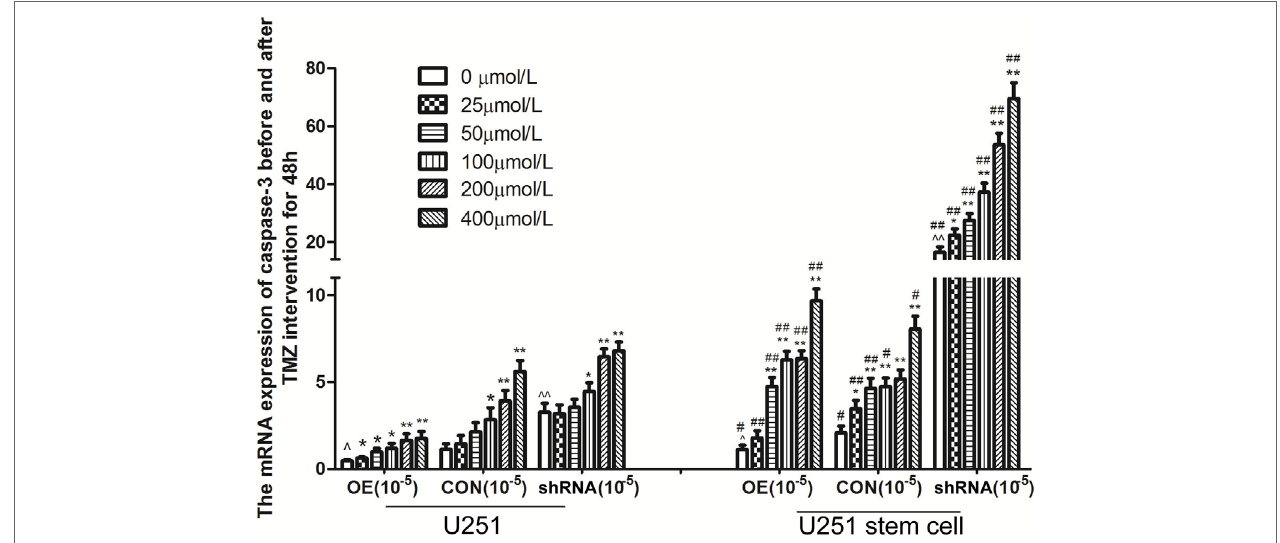
FigUre 8 | The mRNA expression of caspase-3 before and after temozolomide (TMZ) intervention for 48 h in U251 cells and stem cells. Data presented as mean ± SD. *P < 0.05 and **P < 0.01 , compared to the same cells with 0 µmol/L; ^P < 0.05 and ^^P < 0.01, OE compared to CON or siRNA compared to CON in same cell with 0 µmol/L, # P < 0.05 and ## P < 0.01, CSC compared to ACC as the same drug concentration in OE, CON and siRNA, respectively. U251; U251 stem cell; OE, overexpression Livin group; CON, control group; shRNA: shRNA-Livin group.